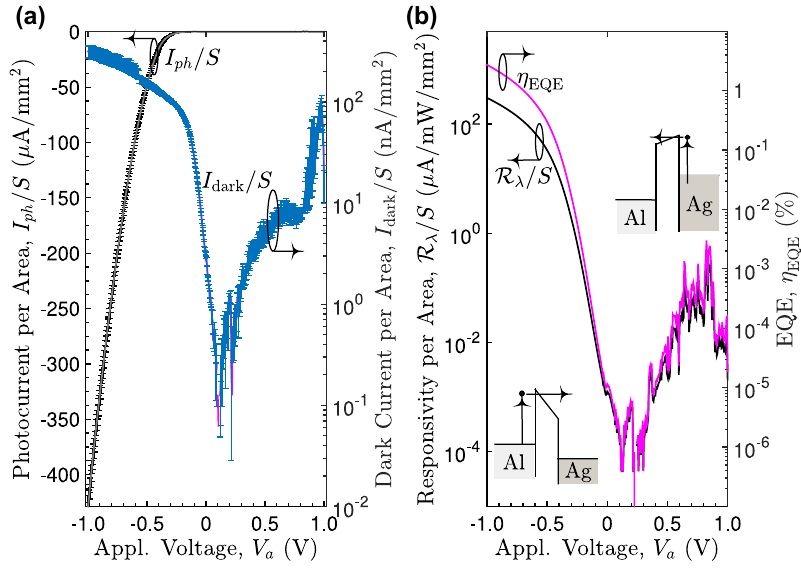
Figure10: Dependenceofthemeasureddark current and photocurrent per unit area (in units of nA/mm 2 and μ A/mm 2 , respectively) on the applied bias with error bars of one standard deviation (a) and the correspond- ingper-unit-arearesponsivity( μ A/mW/mm 2 ) and EQE (b) of the fabricated PD under a constant light illumination of 1.421 mW at 𝜆 = 638.9 0